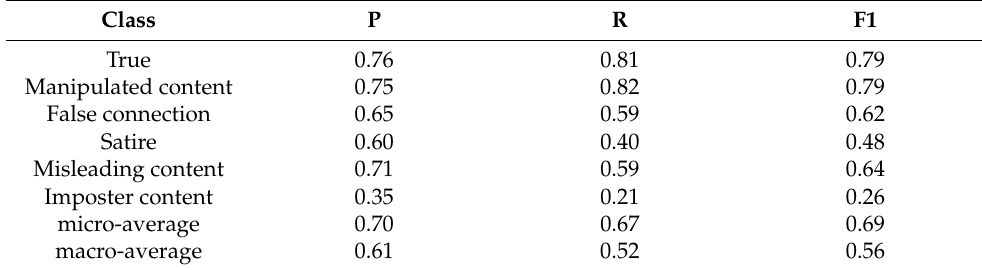
Table 4. Results of CNN with static Glove vectors.